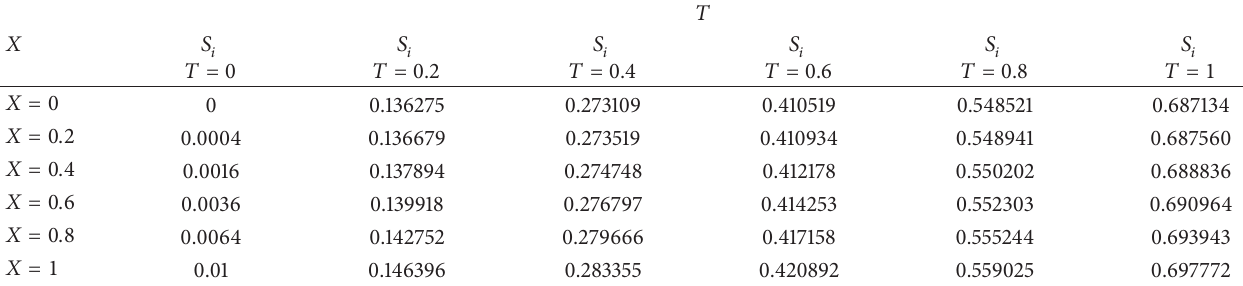
Table 1: Numerical values of saturation of water at different values of time and distance.